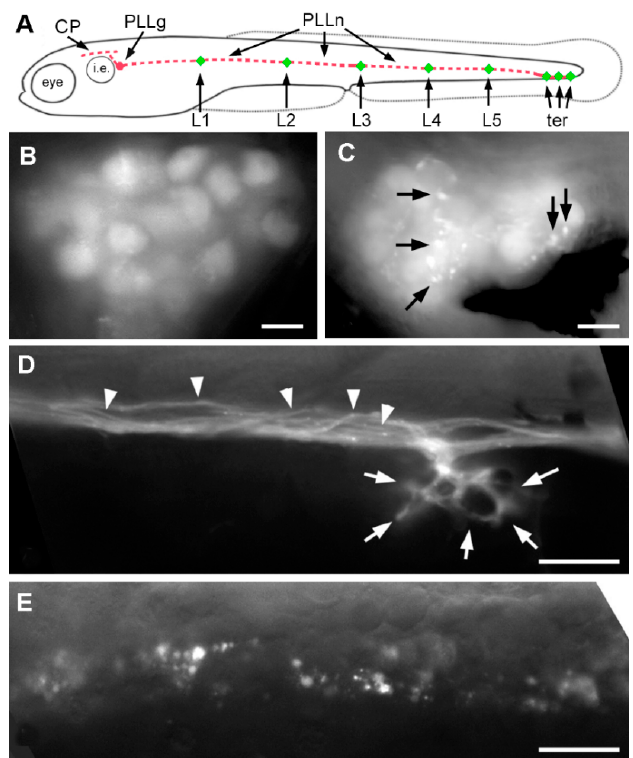
Figure 3. Effect of A6 on the posterior lateral line (PLL) system. ( A ) Scheme of a 4-dpf larva showing the posterior lateral line ganglion (PLLg) just posterior to the otic vesicle (i.e., inner ear), its central projection (CP) extending along the hindbrain, and the peripheral nerve (PLLn) extending along the horizontal myoseptum towards the sensory organs (in red), neuromasts L1–L5 and terminal neuromasts, ter (in green); ( B ) Lateral line ganglion in the nbt-dsred line; ( C ) As in ( B ), in a larva that had been exposed to 20 μ M A6 from 1 to 3 dpf; ( D ) Lateral line nerve and branch to a neuromast in the nbt-dsred line; ( E ) Lateral line nerve in a larva that had been exposed to 20 μ M A6 from 1 to 3 dpf. Arrows in ( C ) indicate fluorescent inclusions. Arrowheads in ( D ) point to individual axons within the PLL nerve; arrowheads show axonal terminations surrounding the mechanosensory hair cells of a neuromast; Scale bars: 10 μ m.